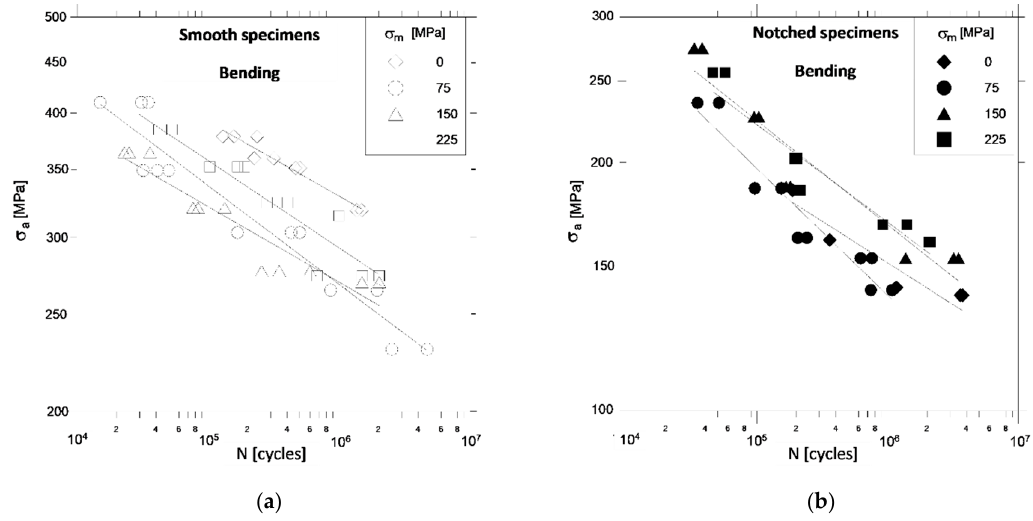
Figure 3. Comparison of fatigue characteristics of smooth ( a ) and notched ( b ) specimens under bending and different values of mean stress.